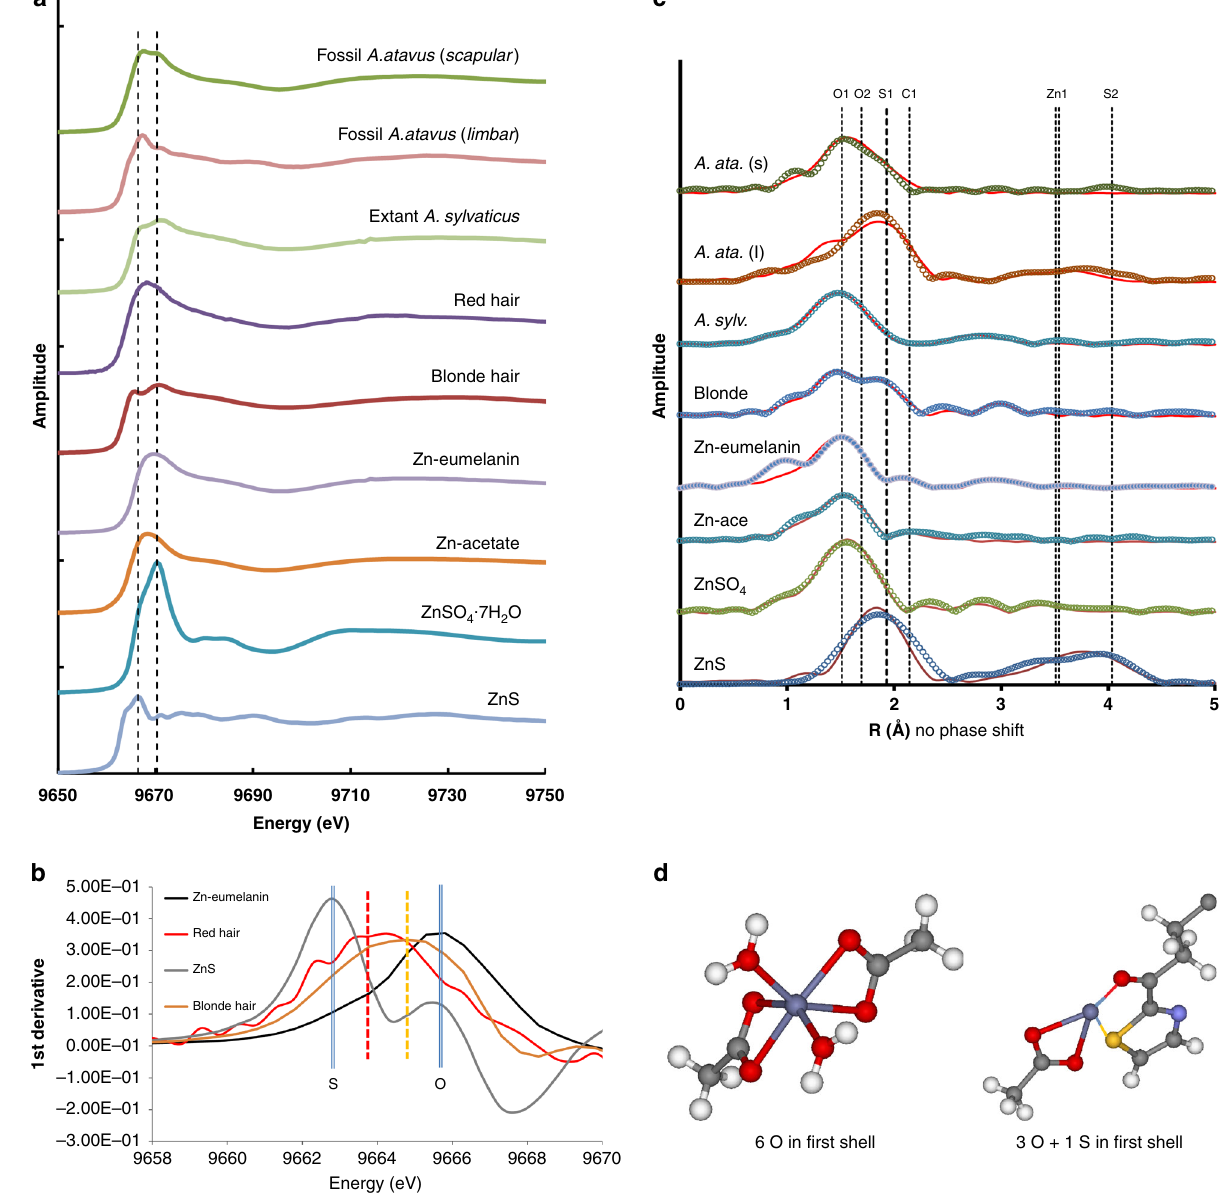
Fig. 4 Zinc X-ray absorption spectroscopy for fossils and standards. a Zinc K-edge XANES spectra for the fossil and extant mouse specimens, human hair, Zn-bonded eumelanin, Zn – acetate heptahydrate, and ZnS. The two vertical lines indicate the absorption spectrum maxima for pure fi rst shell Zn – S and pure fi rst shell Zn – O species. b First-derivative analysis in the vicinity of the sulfur “ white line ” region. The ZnS spectrum is displaced to the low-energy side and the Zn – O spectrum from Zn-substituted eumelanin is displaced toward high energy, with the two pheomelanin bearing hair standards intermediate between the two. c Fourier-transformed EXAFS showing relative positions of backscatterers around the Zn central absorber. The heavy dashed line indicates the Zn – S shell. All labels on the vertical lines refer to element shells given in Table 1. Note that the distance values in this fi gure are not phase shifted and hence are smaller than those presented in the table, but relative positions remain the same. d The two Zn coordination environments resolved in both the extant hair and fur and in the fossil mouse fur. The high abundance of organosulfur-bonded Zn in the fur and skin regions of the A. atavus fossil is most likely due to an originally high concentration of pheomelanin which is enriched in the tetrahedrally coordinated Zn complex shown in the right of the panel. (Zn = dark gray; C = light gray; O = red; S = yellow; N = blue; H =